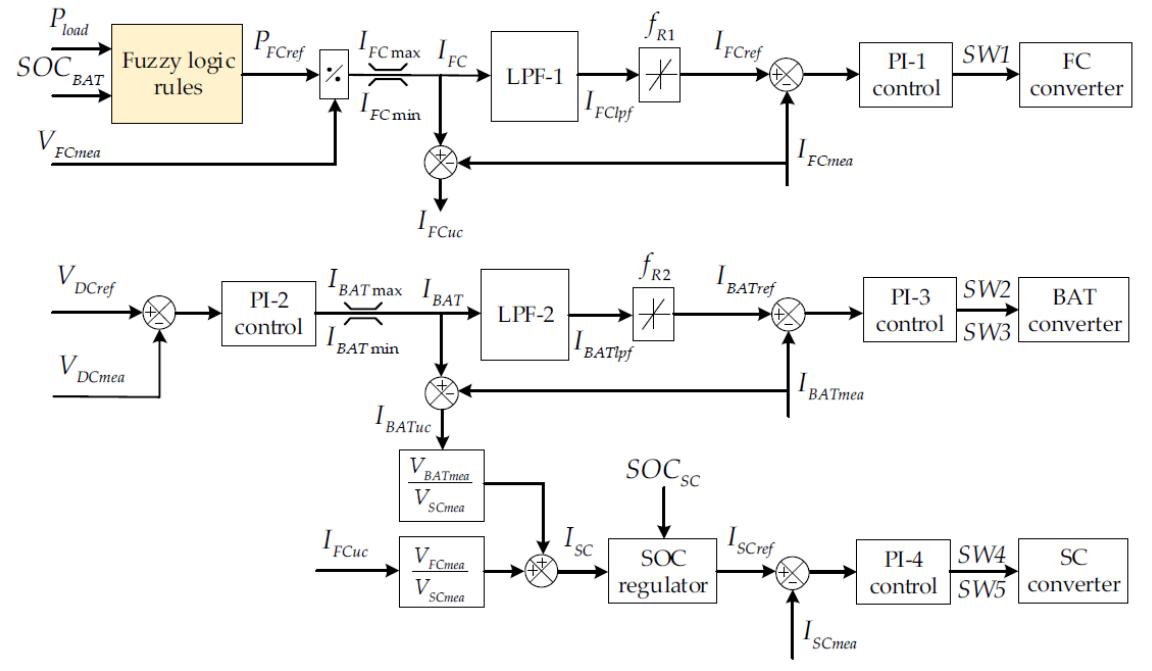
Figure 8. Energy control strategy for the HPS.